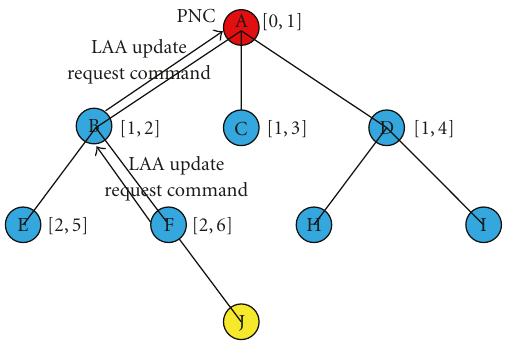
Figure 4: An example of the address assignment based on